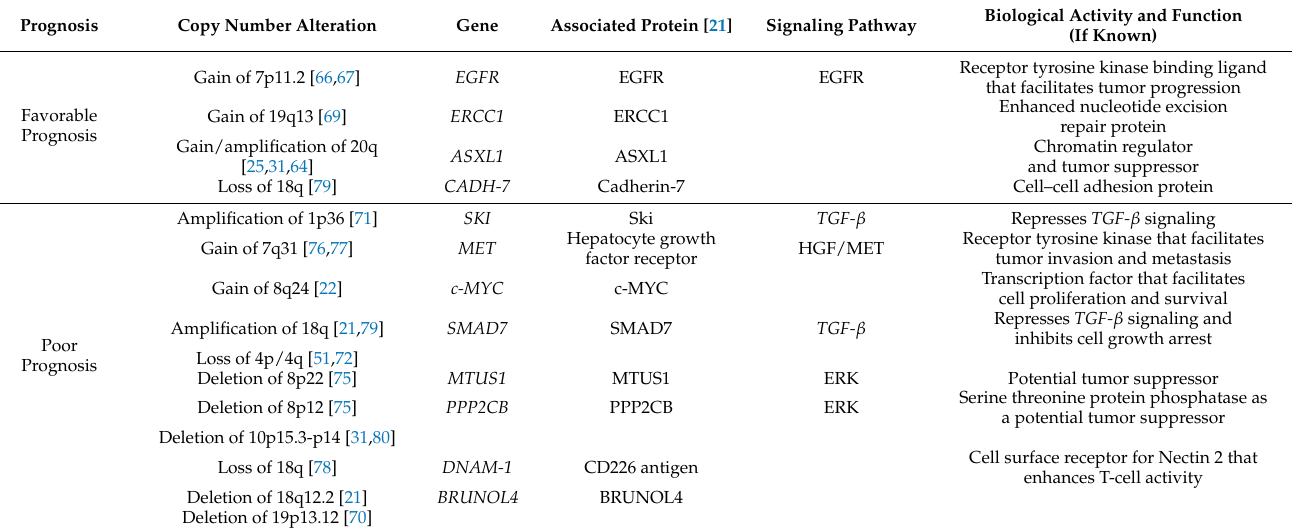
Table 2. Copy number alterations and their associated genes and functions with prognostic roles in colorectal